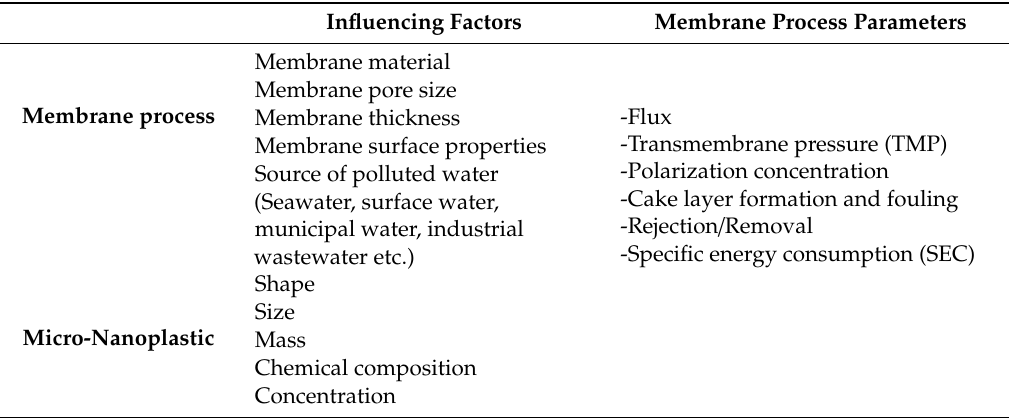
Table 1. Influencing factors and membrane process parameters to be considered for microplastic (MP )removal by membrane processes.